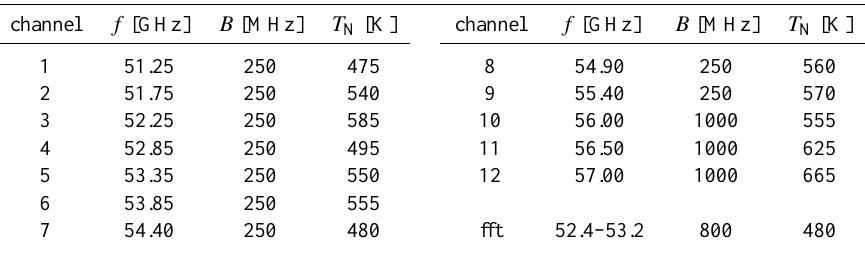
Table 2. Specifications of the 12 tropospheric channels (ch1–ch12) and of the FFT spectrometer (ch_fft) with frequency f , the bandwidth B and receiver noise temperature T N